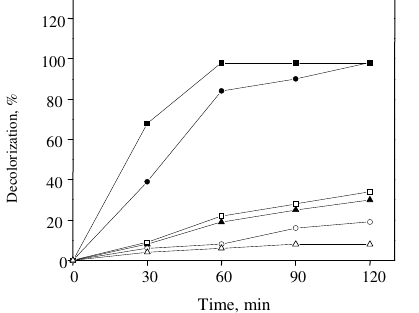
Figure 3 . Effect of concentration of Reactive Red 120 on the efficiency of decolourization in UV light.( ■ ) TiO 5 mg/L, ( ● )TiO /UV 10 mg/L, ( ▲ )TiO 2 UV 50 mg/L, ( □ ) UV 5 mg/L, ( ○ ) UV 10 mg/L, ( ∆ ) UV 50 mg/L